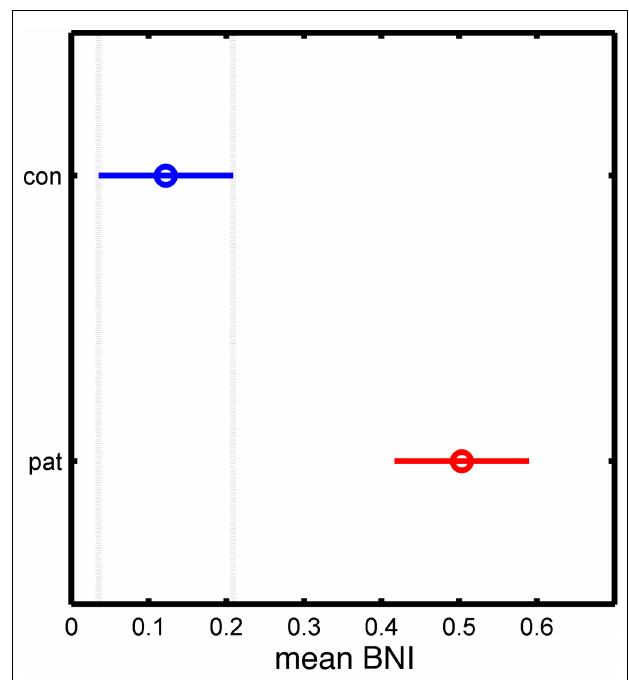
FIGURE 4 | Statistical analysis of the significant differences between control and patient groups based on the mean BNI measure .The y -axis separates the two groups, while the x -axis represents the mean BNI value. The horizontal line and the circle represent the variance and the mean value of BNI,